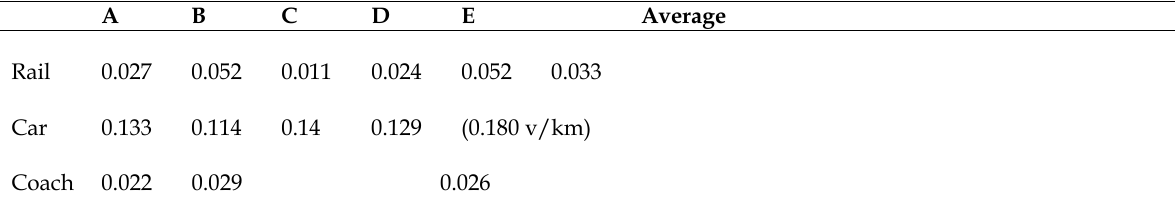
Table 1. Mode Specific CO 2 Emission Factors for Transport (kg /passenger